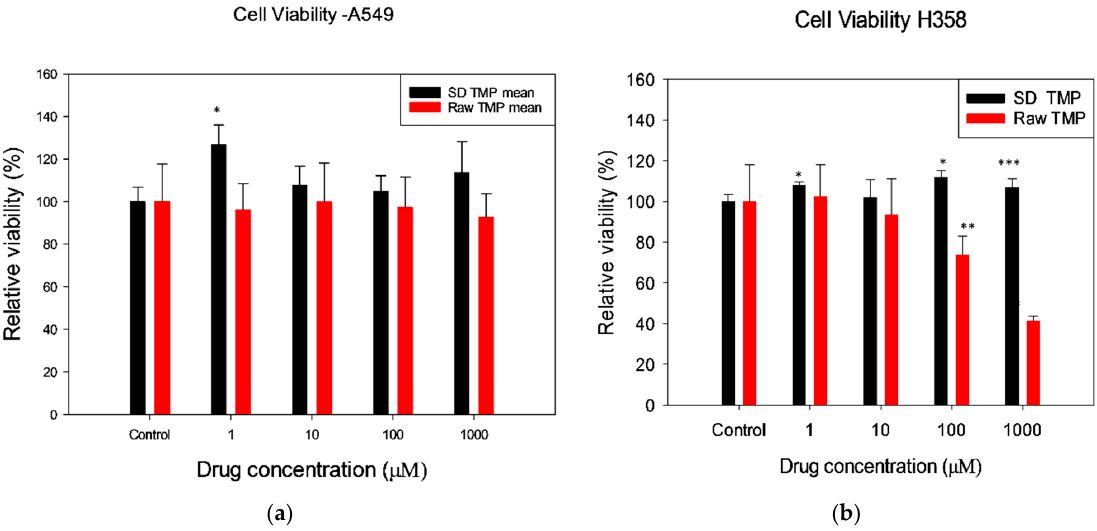
Figure 8. In Vitro Vell Viability of: ( a ). A549 and ( b ). H358 human pulmonary cell lines. * p value < 0.001, ** p value 0.010, *** p value 0.015. ( n = 6, Mean ± SD).